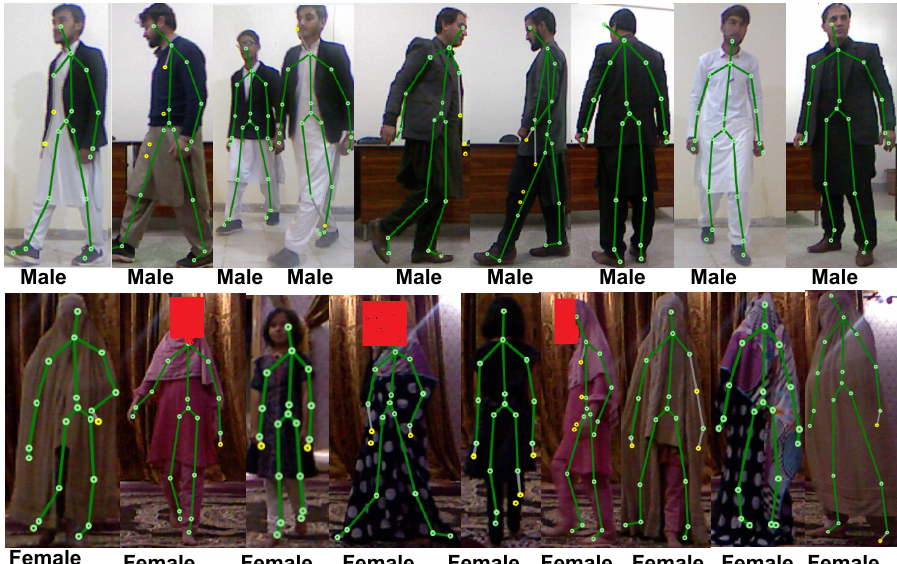
Figure 5. Walking of different subjects from different directions.